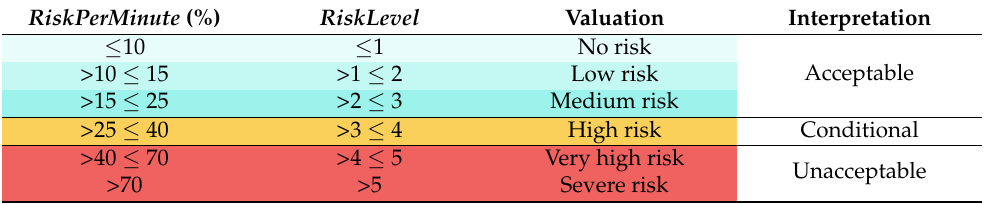
Table 5. Scoring and interpretation of the risk reached at a joint throughout the entire work